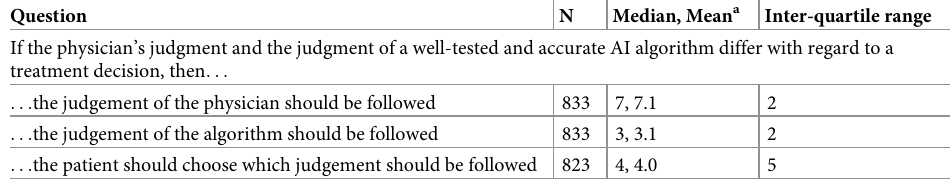
Table 2. Conflicts between judgement of physician and AI.